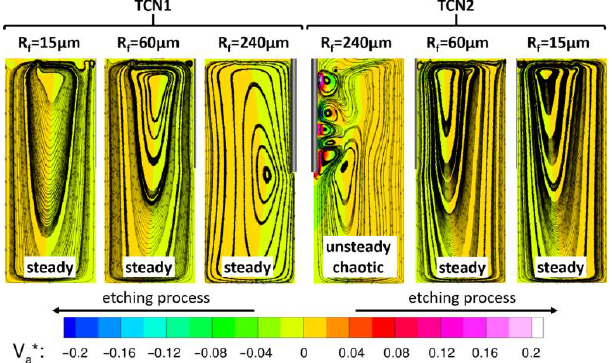
Figure 10. Variation of flow structures due to fiber etching for TCN1 and TCN2 cases. Intact fiber: 240 μm; etched fiber: 60 μm and 15 μm.